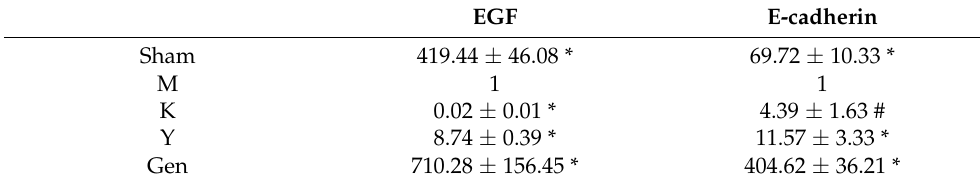
Table 2. Relative mRNA expression of EGF,